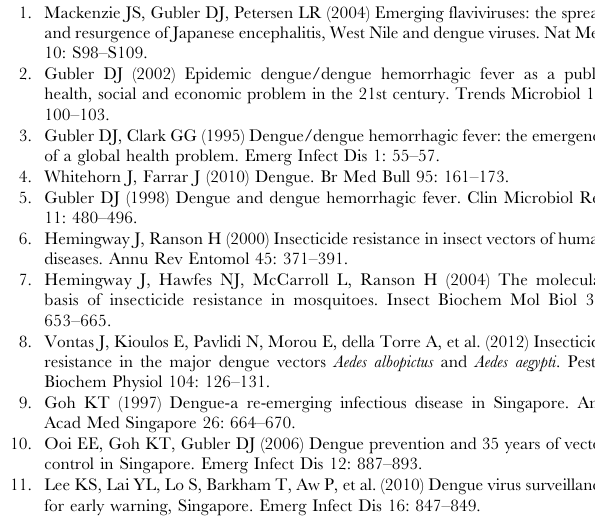
(PDF) Figure S3 Full length cDNA and deduced amino acid sequence of CYP6BB2 from SP and SMK strains of Aedes aegypti . The red letter indicates the only nucleotide differentiate between SP (cytosine) and SMK (thymidine) in this region. The 6BB2F21 and 6BB2R22 primers were used for genotyping. The poly(A) addition signal (aataaa) is also underlined. (PDF) Figure S4 Multiple alignments of CYP9M6 amino acid sequences identified from Liverpool, SP, and SMK strains of Aedes aegypti . Hyphens indicate identical amino acids to the sequence of Liverpool strain which was used for the genome project. Asterisks indicate stop codons. (PDF) (XLSX) Table S2 In vitro metabolism of [ 14 C]-permethrin by microsome of SP and SMK strains of Aedes aegypti . (PDF) Table S3 Metabolism of [ 14 C]-permethrin by CYP9M6v1, CYP9M6v2, and CYP6BB2 expressed in Sf9 cells.